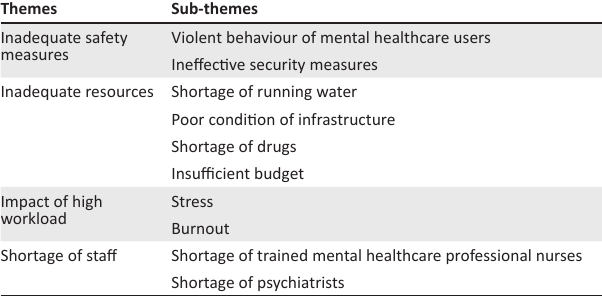
TABLE 1: Themes and sub-themes that emerged from the